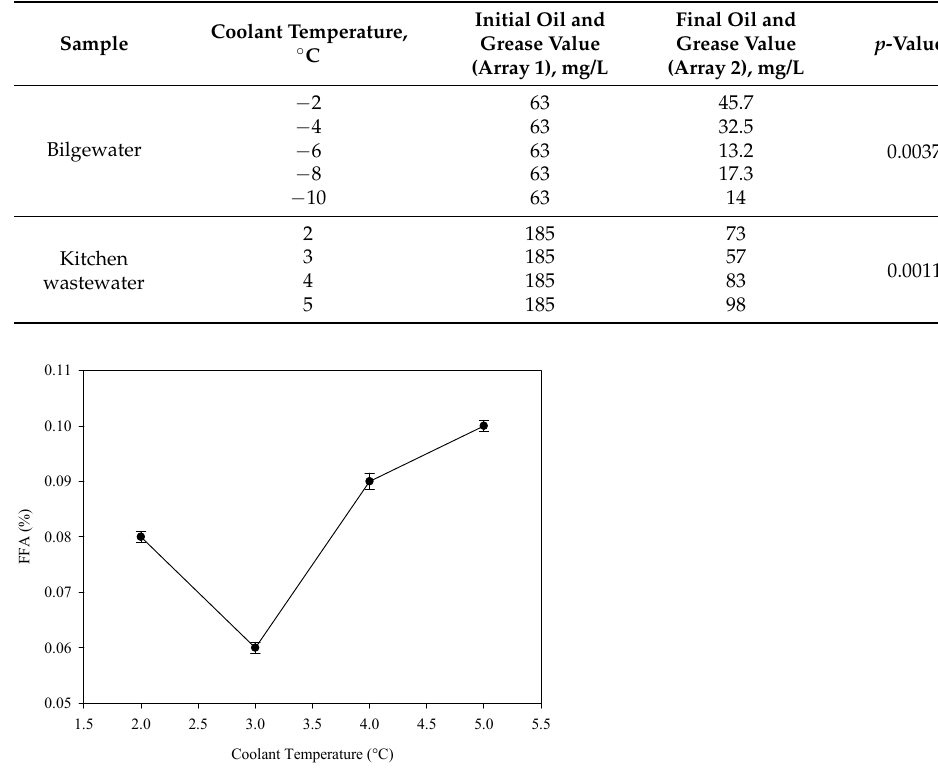
Figure 3. Changes of FFA (%) content in the separated oil from the kitchen wastewater at different coolant temperatures (°C). coolant temperatures ( ◦